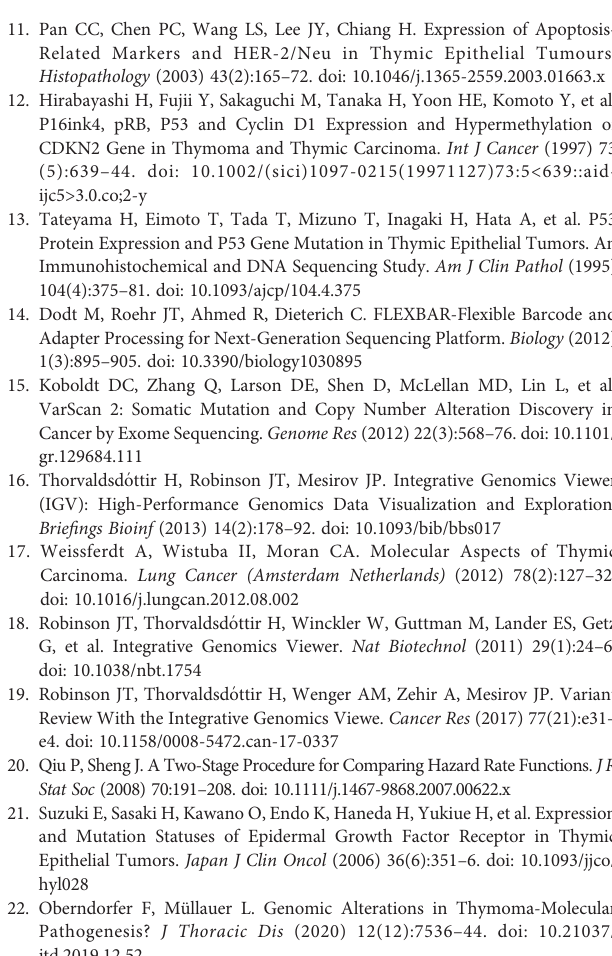
Supplementary Figure 3 | The Kaplan-Meier survival curve of CDKN2A(+) vs. CDKN2A(-) TET patients. A: CDKN2A(+) vs. CDKN2A(-) TET patients of DFS in our